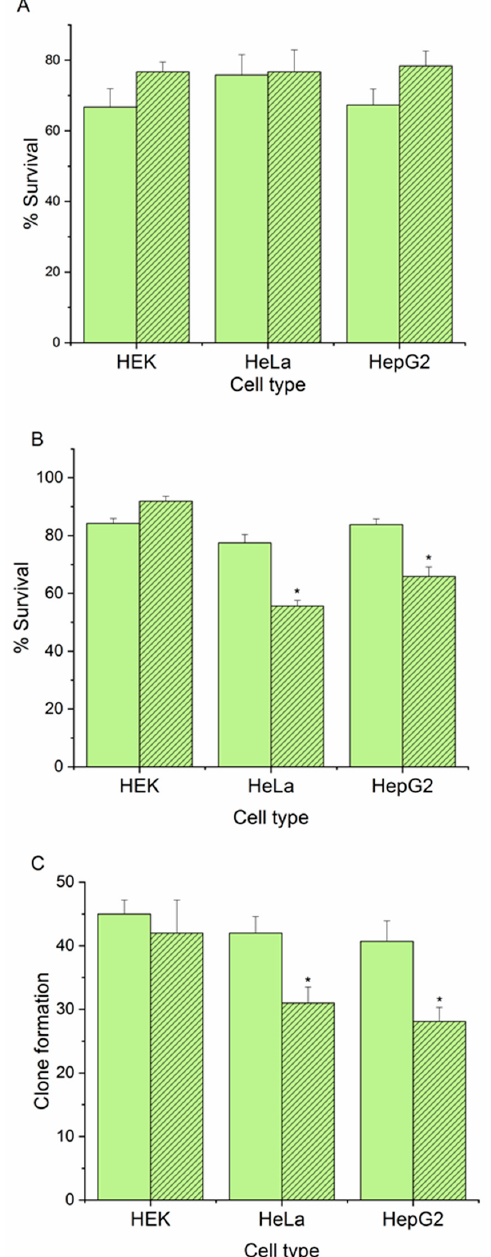
Figure 7. Cytotoxicity assays of MNP-1 ( A ) and MNP-4 ( B ) and clone formation of MNP-4 ( C ) at 150 µ g/mL against the low-FR expressing HEK cells and the high-expressing FR HeLa and HepG2 cells in the absence (full color) or presence (patterned color) of a magnetic field. Results are means ± 1 standard deviation ( n = 5). * p < 0.05 versus cells that were not subjected to the magnetic